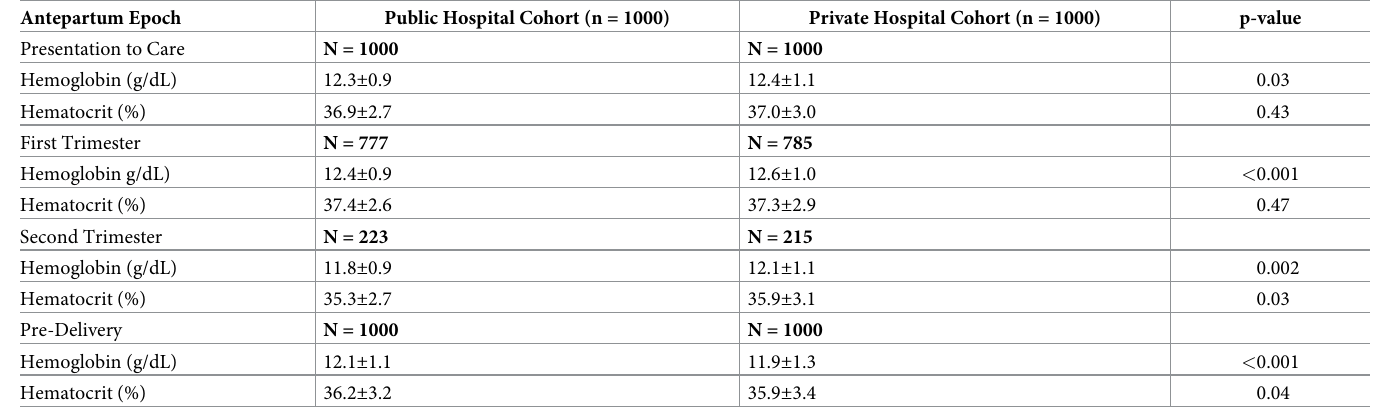
Table 2. Average hemoglobin/hematocrit per antepartum epoch. Antepartum Epoch